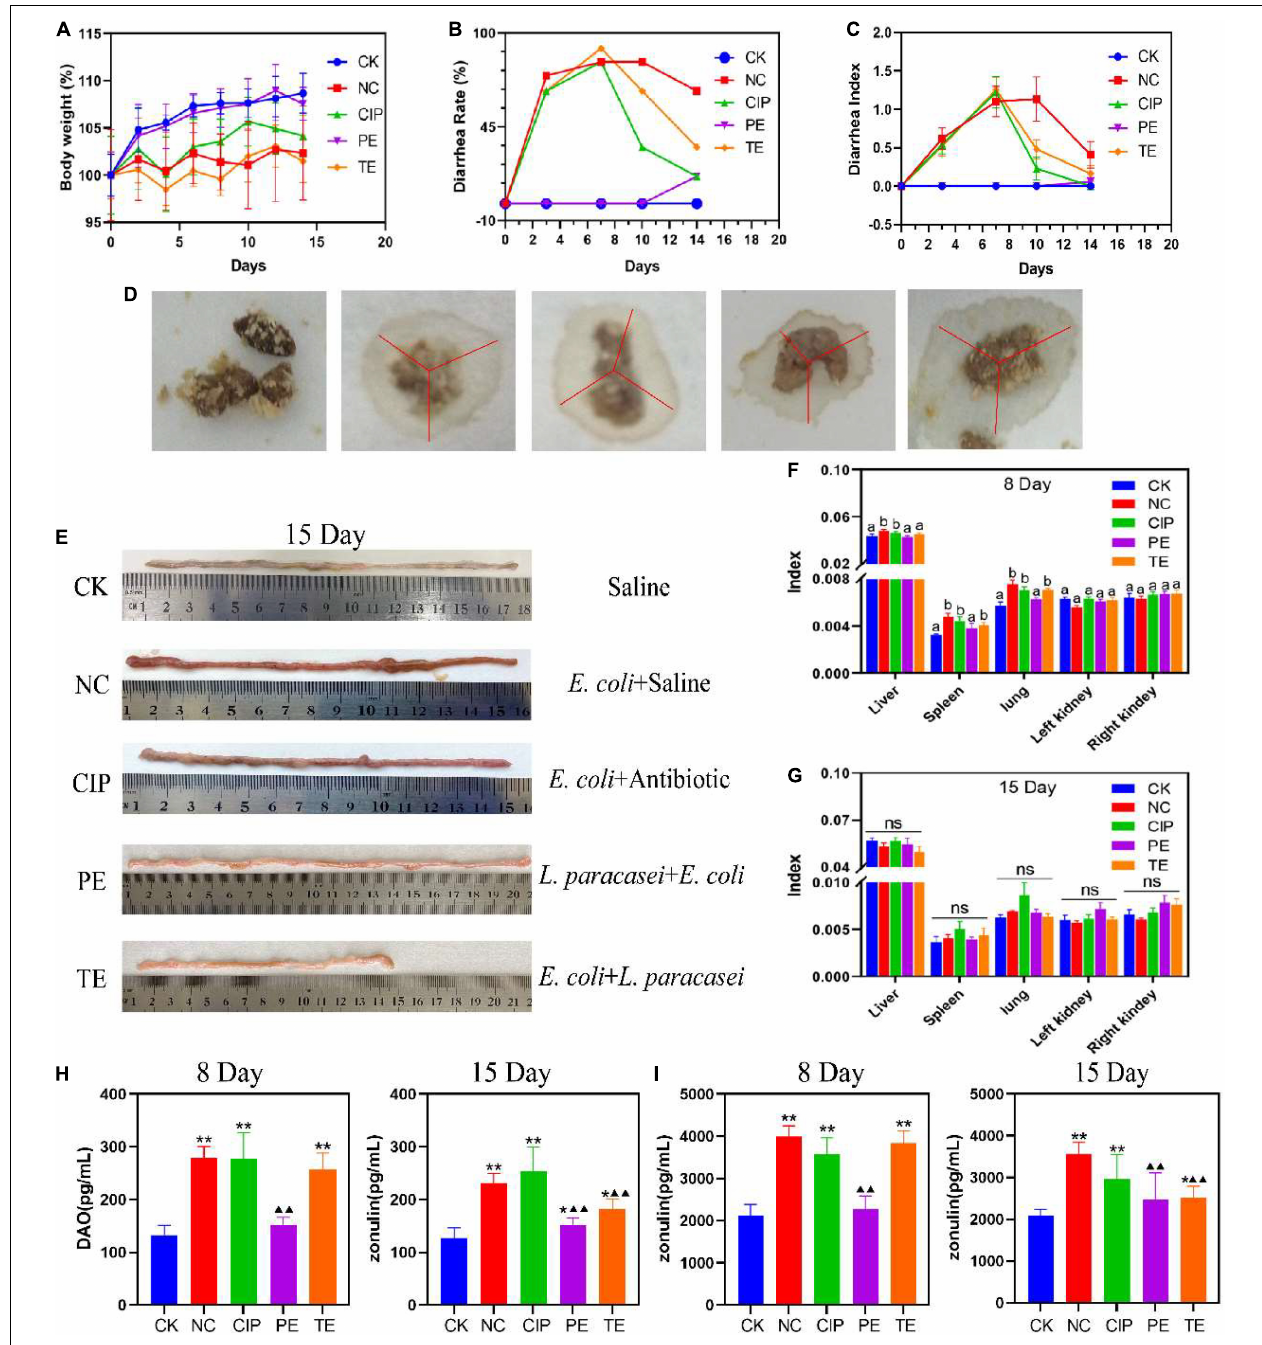
FIGURE 2 | Changes in the parameters of mice during the administration with L. paracasei . (A) Body weight. (B) Diarrhea rate. (C) Diarrhea index. (D) Fecal diameter. (E) Ileum injury. (F,H) the organ index at the days of 8 and 15. Different letters in each figure indicates significant in the data at P < 0.05. (H,I) Representative the expression of DAO and zonulin. * Represent compare with CK group. * P < 0.05; ** P < 0.01; (cid:78) represent compare with NC group. (cid:78) P < 0.05; (cid:78)(cid:78) P < 0.01. Calculated by Student’s t -test. CK, the normal group; NC, the negative group; CIP, the diarrhea model group treated with ciprofloxacin; PE, the diarrhea model group prevented with L. paracasei ; TE, the diarrhea model group treated with L. paracasei.